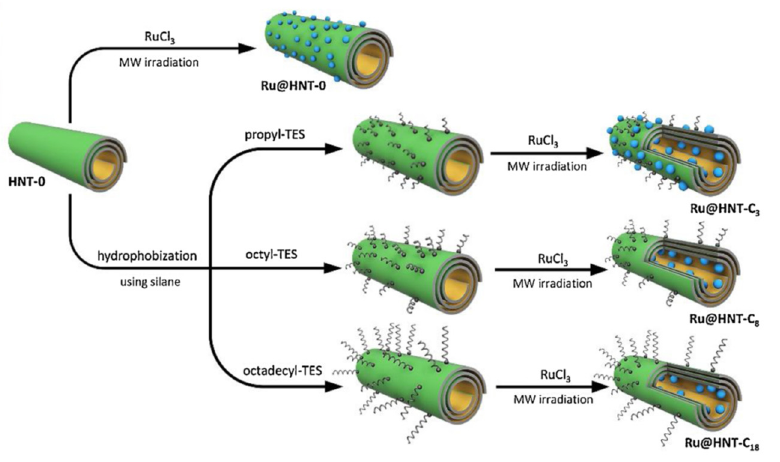
Figure 9. Scheme of the hydrophobization and ruthenium deposition. Reproduced with permission from ref. [97]. Copyright 2021